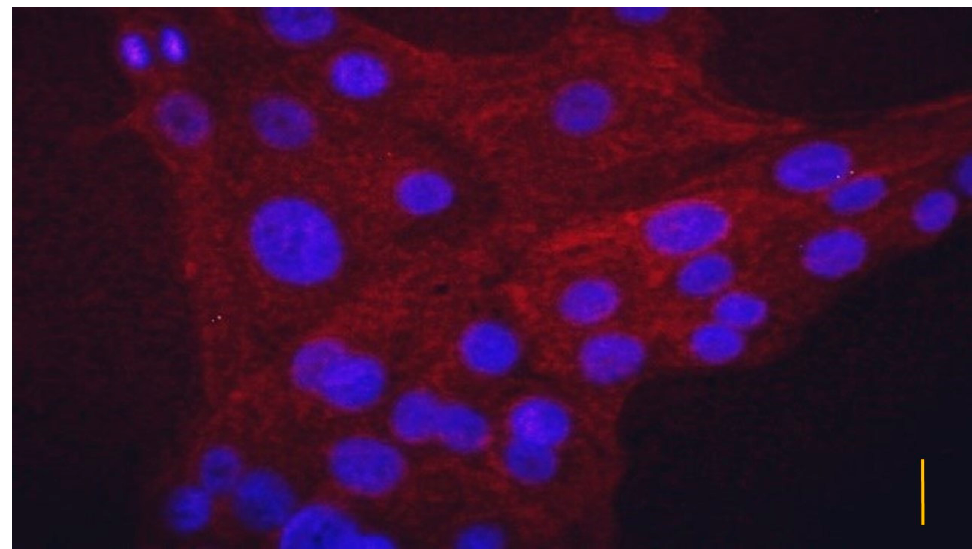
Figure 3. Immunofluorescent staining of uroepithelial cell culture with eFluor labeled pan-cytokeratin antibody on day 1 after plating. Blue color indicates diamidino phenylindole (DAPI) labeled cell nuclei, while red color shows epithelial cells detected with eFluor labeled pan-cytokeratin antibody. (bar = 3.5 µm).